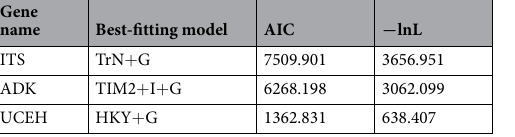
Lichens are more effective than cyanobacteria at reducing soil erosion because the fungal hyphae of the lichen thallus penetrate more deeply and the tissue extends above the soil surface 52 . In summary, based on morphological and molecular phylogenetic data, two new putative species, Endocarpon sp. 1 and Endocarpon sp. 2, have been described under the names Endocarpon deserticola and Endocarpon uni- foliatum , respectively. In previous studies, the lichen species Endocarpon pusillum exhibited drought resistance 15 and sand and carbon fixation 9, 11 , and thus served as an important species for desert bio‐carpet engineering and the study of stress tolerance mechanisms in lichens in China 12–14 . The two new species, E. deserticola and E. uni- foliatum , exhibit different morphological and phylogenetic characteristics from those of E. pusillum and may also play important roles in desert sand stabilisation. Further characterisation of features such as stress tolerance and